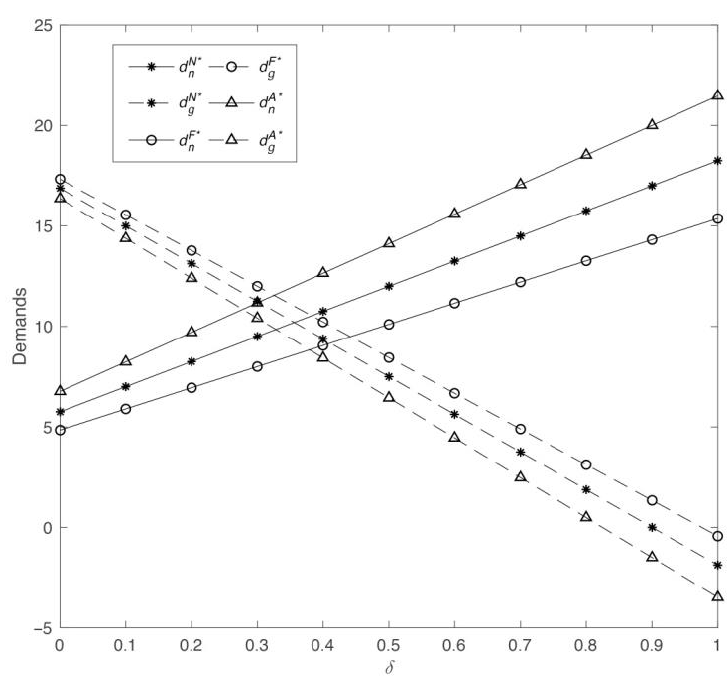
Figure 3. The change in demands with parameter δ.